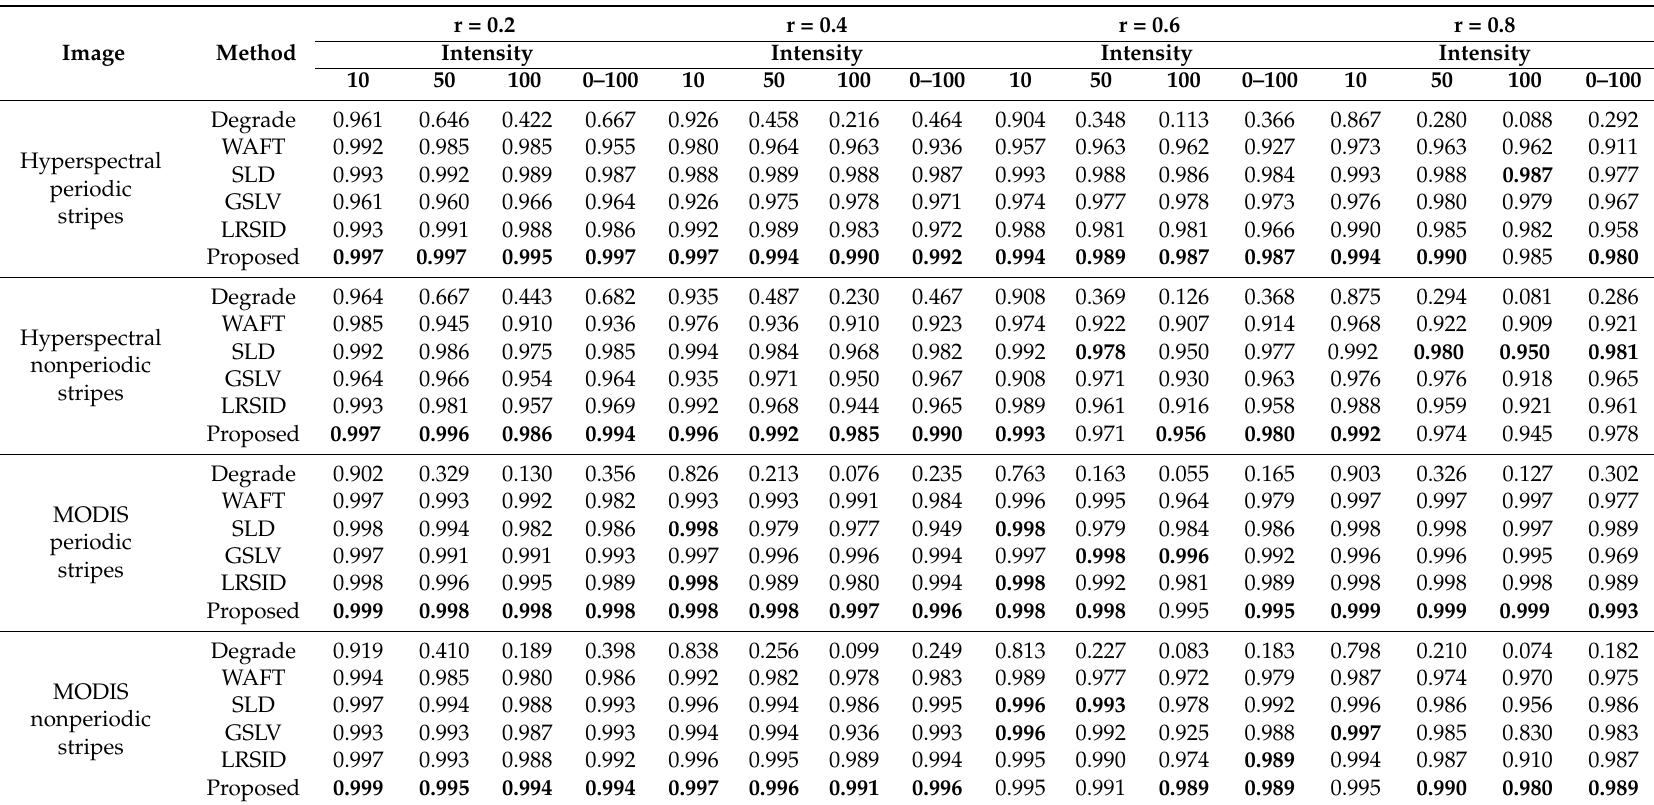
Table 2. SSIM results of the test methods for different stripe noise